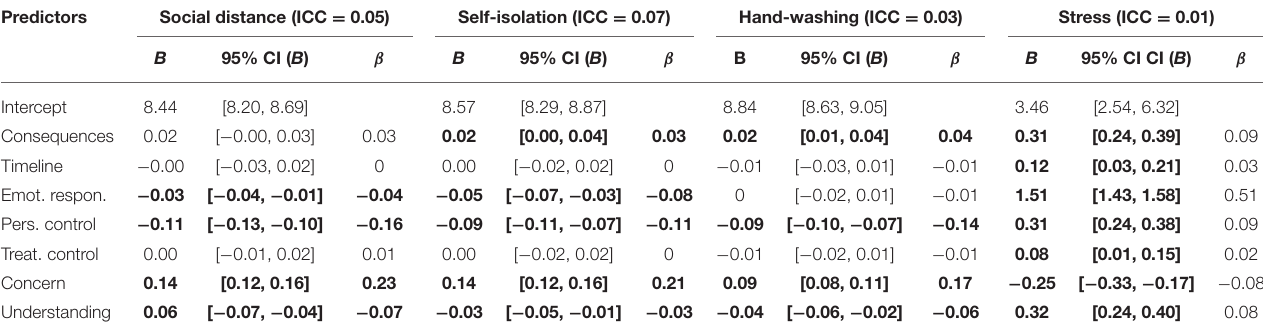
TABLE 6 | Multilevel modeling estimates and ICC values for COVID-19 behavioral outcomes and stress.